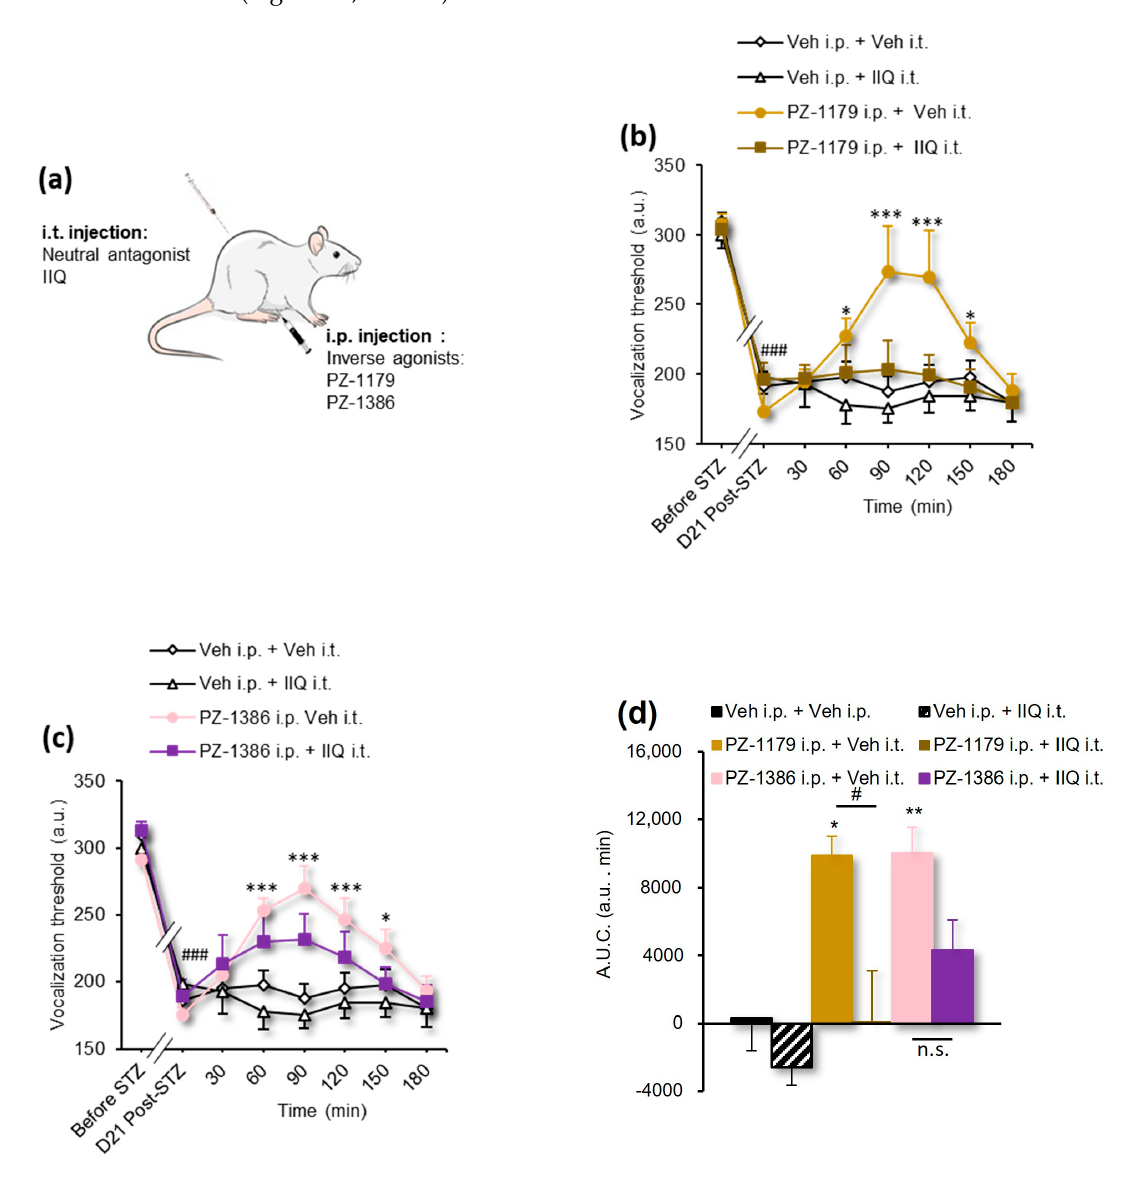
Figure 2. 5-HT 6 receptor constitutive activity is involved in mechanical hyperalgesia (paw pressure test) in STZ diabetic rats. ( a ) Schema illustrating the route of administration of 5-HT 6 receptor ligands in experiment illustrated on panels b–d; ( b ) Intrathecal administration of IIQ (2 nmol/rat) but not vehicle (water for injections, 10 µ L/rat) suppresses the antihyperalgesic effect of PZ-1179 (25 µ mol/kg, i.p.) and ( c ) PZ-1386 (25 µ mol/kg, i.p.), respectively ( n = 6–9/group). ### p < 0.001 vs. values measured before STZ; * p < 0.05, ** p < 0.01, *** p < 0.001 vs. values measured before drug/vehicle injection (D21 Post-STZ), 2-way ANOVA; ( d ) Area under the curve (A.U.C.) of vocalization threshold variations in STZ rats calculated by the trapezoidal rule (in a.u. min). * p < 0.05, ** p < 0.01, vs. Veh + Veh group; # p < 0.05 vs. corresponding group, 1-way ANOVA.